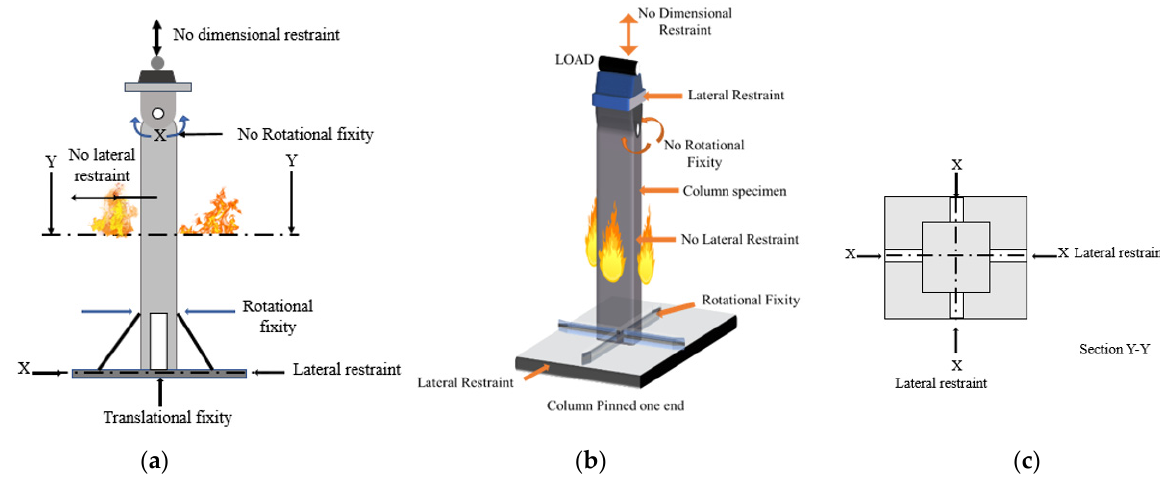
Figure 8. Restraints for columns pinned at one end: ( a ) 2D, ( b ) 3D, and ( c ) section.